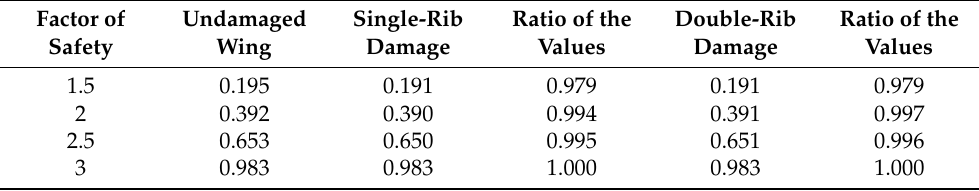
Table 22. Comparison of Hashin fiber tensile failure criterion in the undamaged wing and wing containing rib